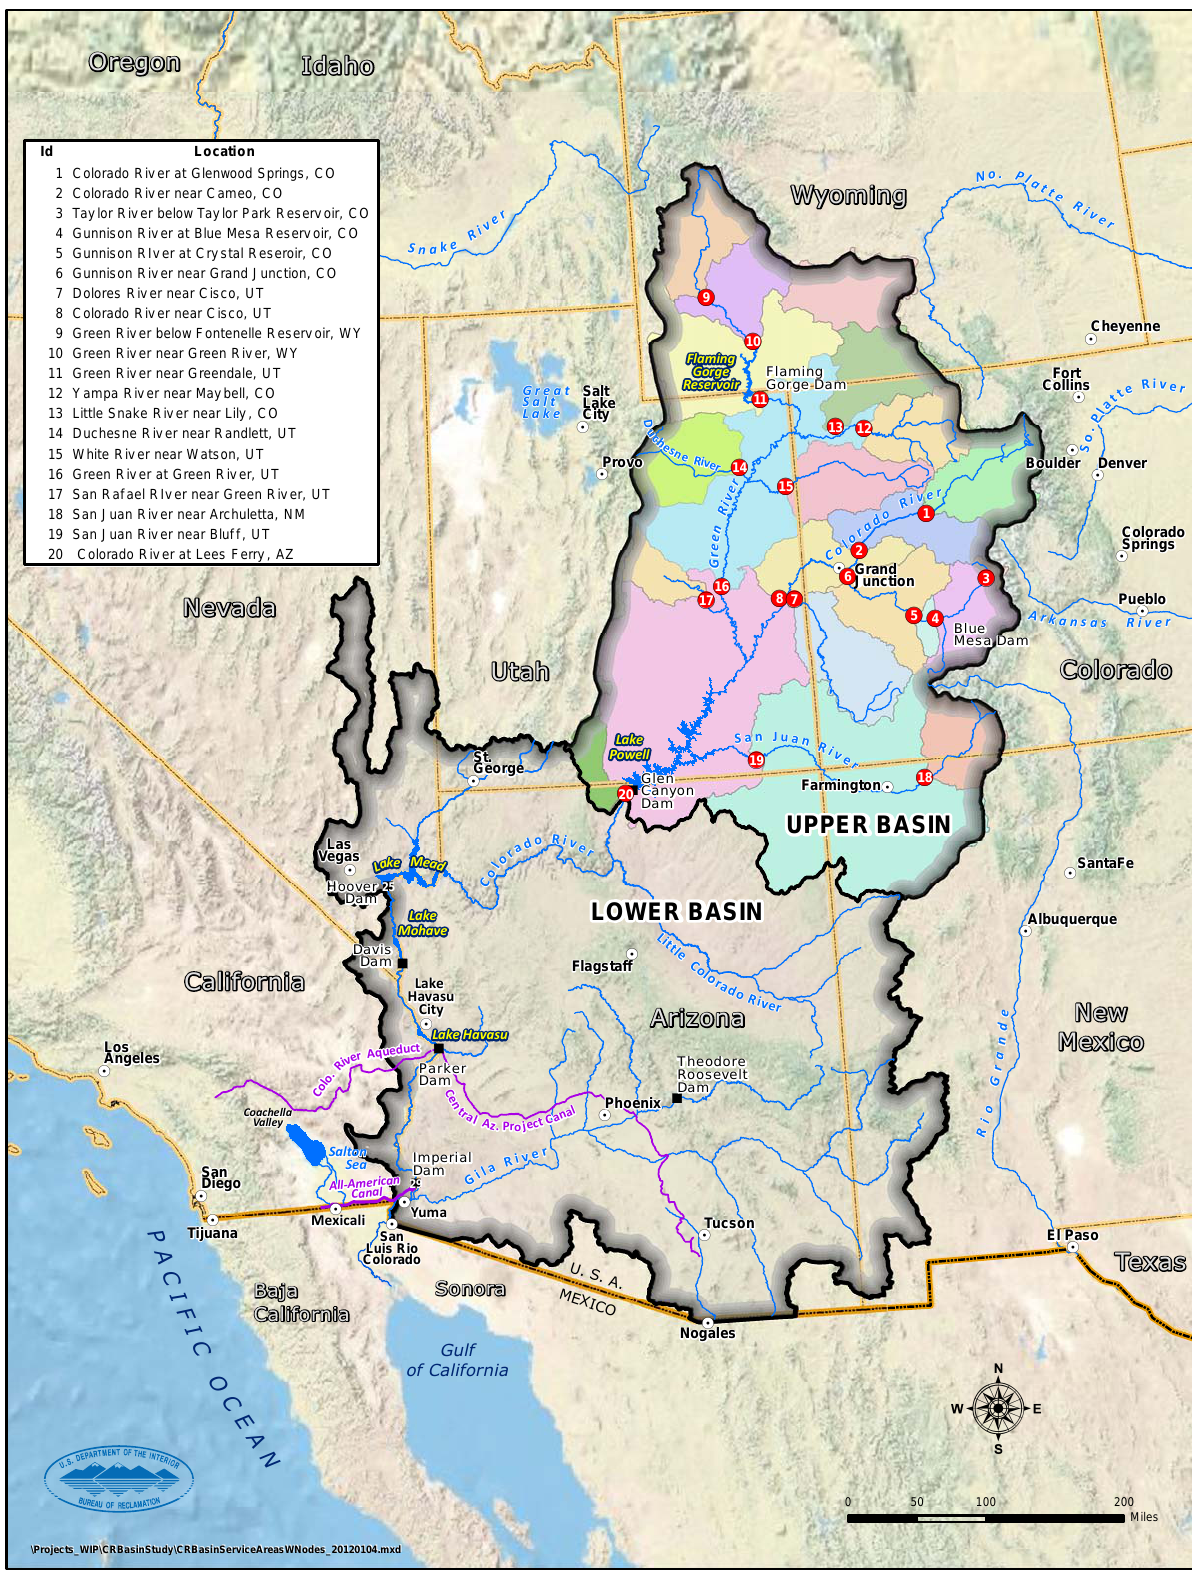
Fig. 1. Colorado River Basin and CRSS inflow points above Lees Ferry,